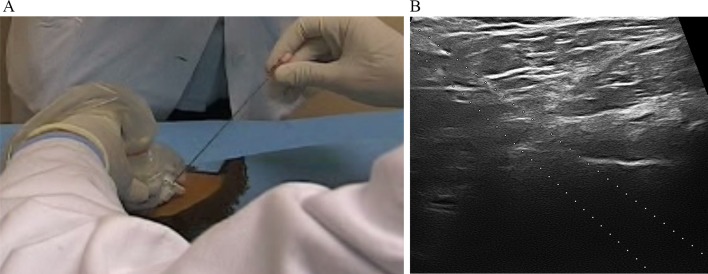

(A) Intra-articular injection performed by inserting a 18-gauge needle in the sterile guide with an antero-inferior approach; (B) intracapsular positioning of the needle was monitored in real time by direct US visualization of the needle on the screen of the ultrasound machine.